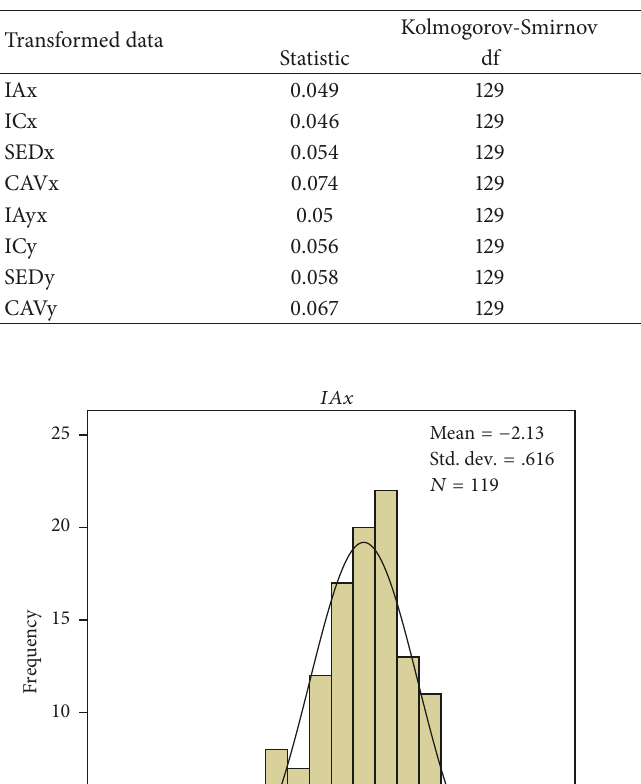
Table 4: Tests of normality.